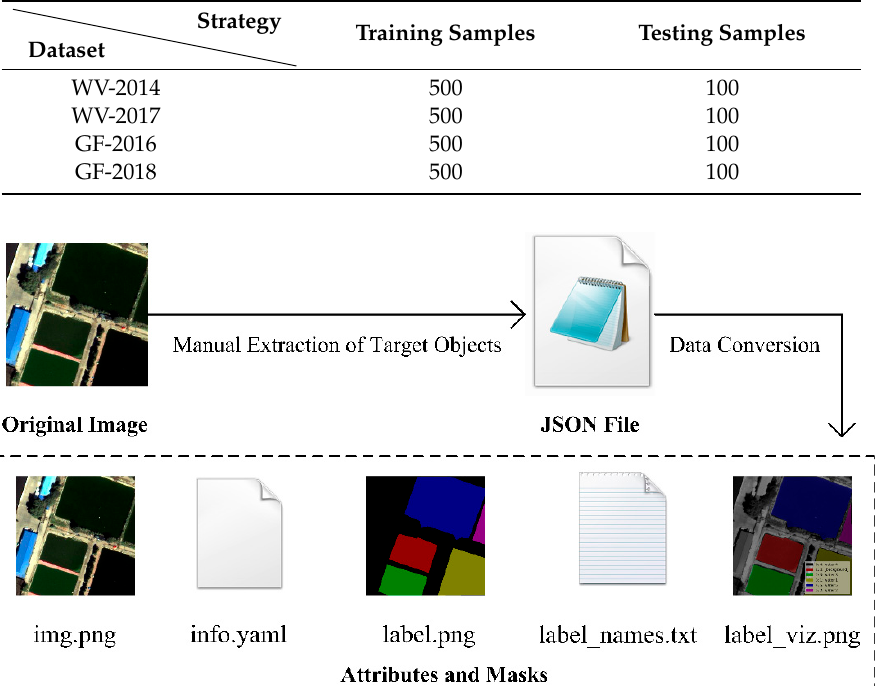
Table 5. The strategy of training / testing division for di ff erent datasets.